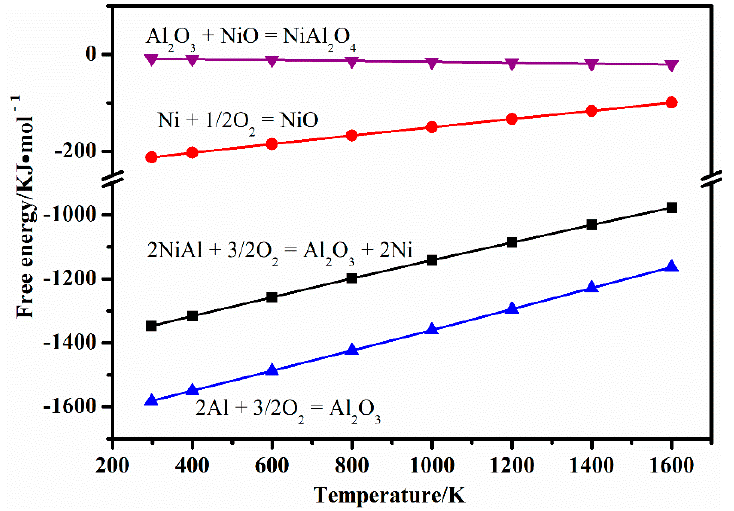
Figure 6. Gibbs free energy of different reactions at different temperatures [35].